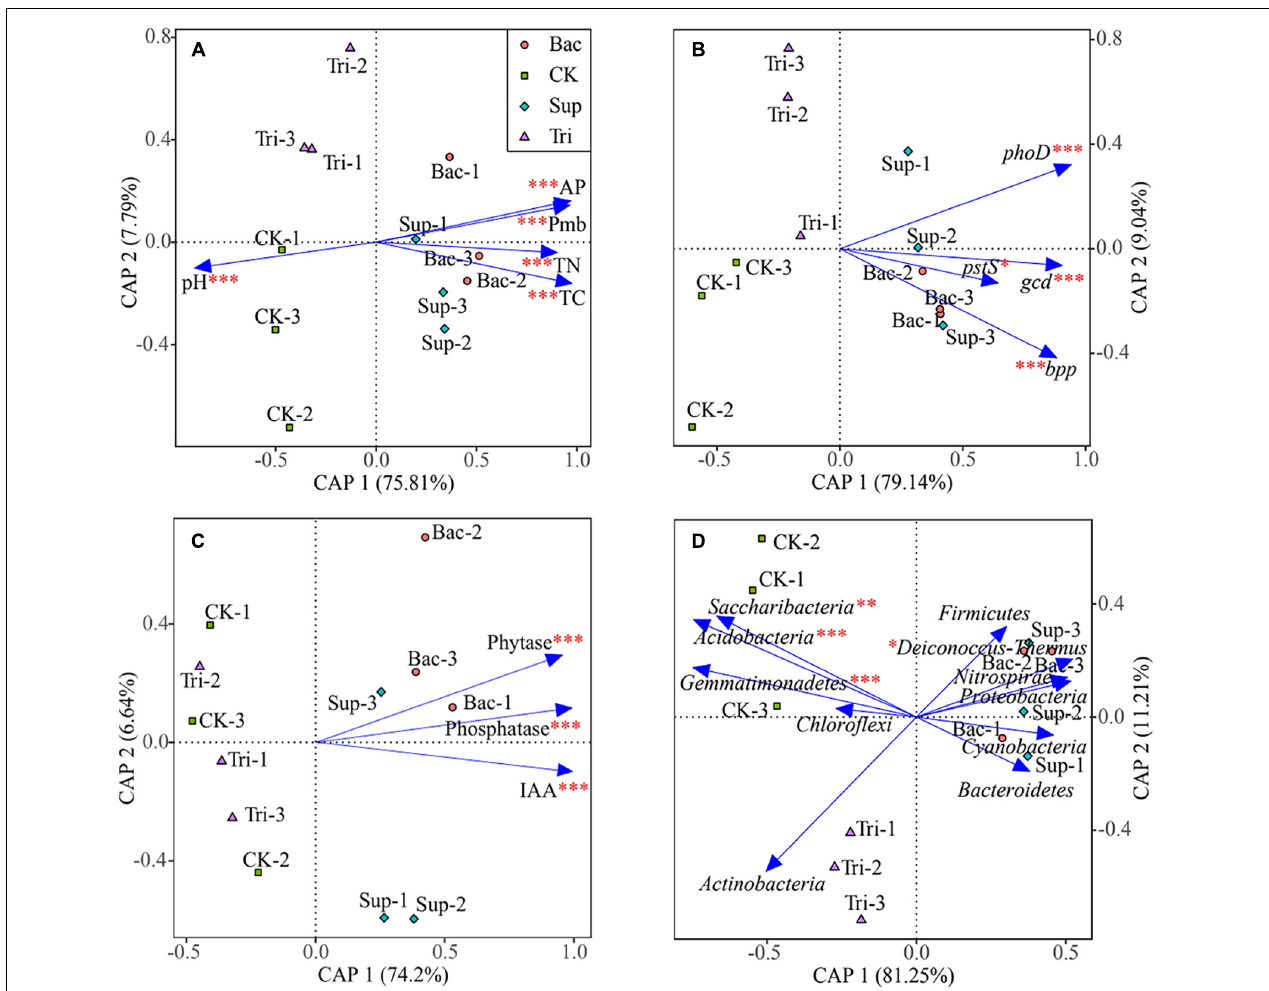
FIGURE 5 | Canonical analysis of principal coordinates showing effects of soil physicochemical properties (A) , abundances of phosphorus-cycling-related genes (B) , cell exudates (C) , and bacterial abundances at phylum level (D) on vegetation properties. The significance of factors was determined using permutational multivariate analysis of variance (PERMANOVA) and is reflected by asterisks next to the variable names. Asterisks denote significance ( ∗ p < 0.05; ∗∗ p < 0.01; ∗∗∗ p <